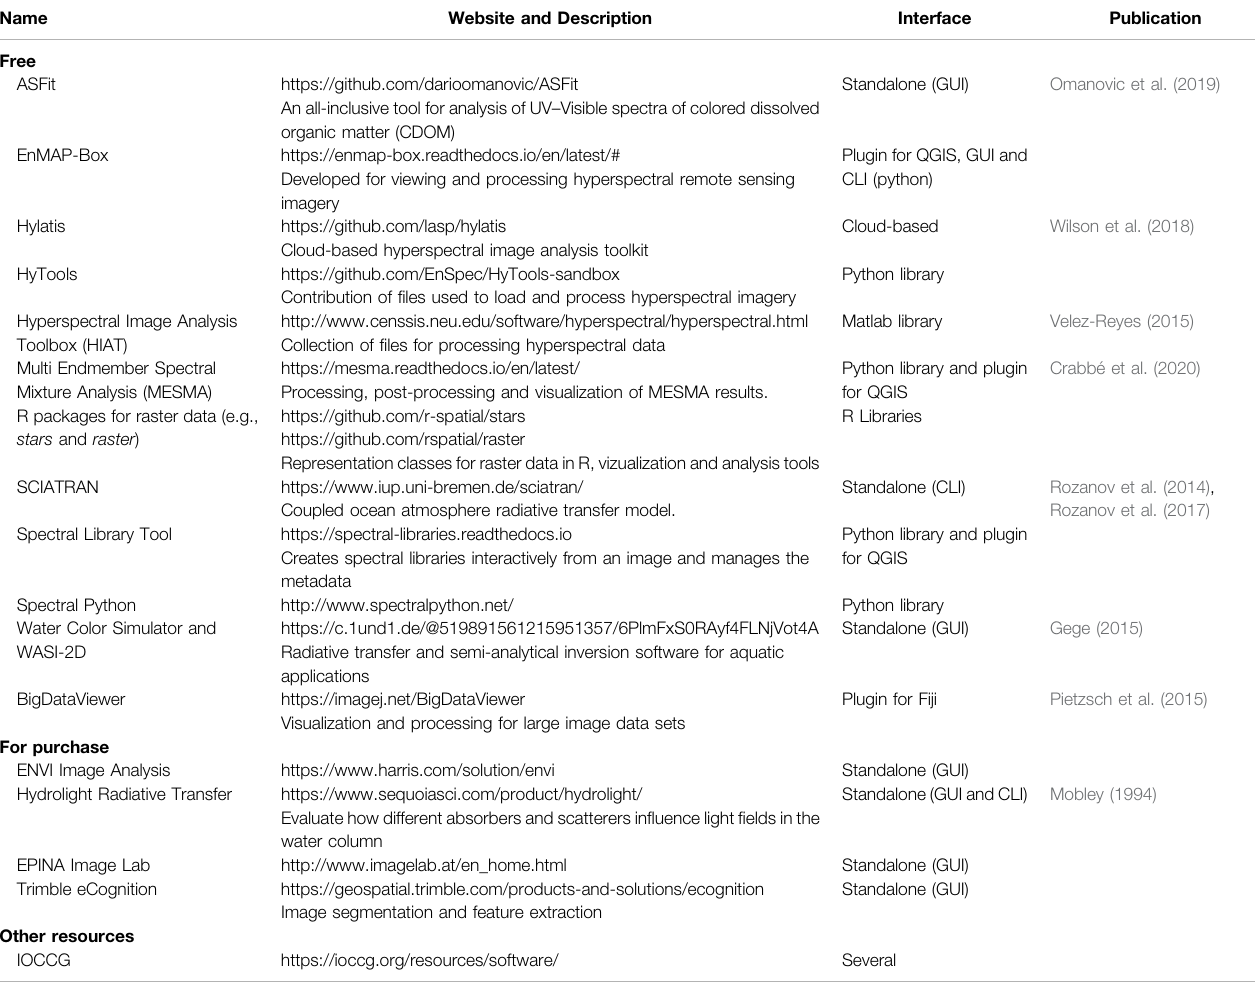
TABLE 2 | Software available for hyperspectral data